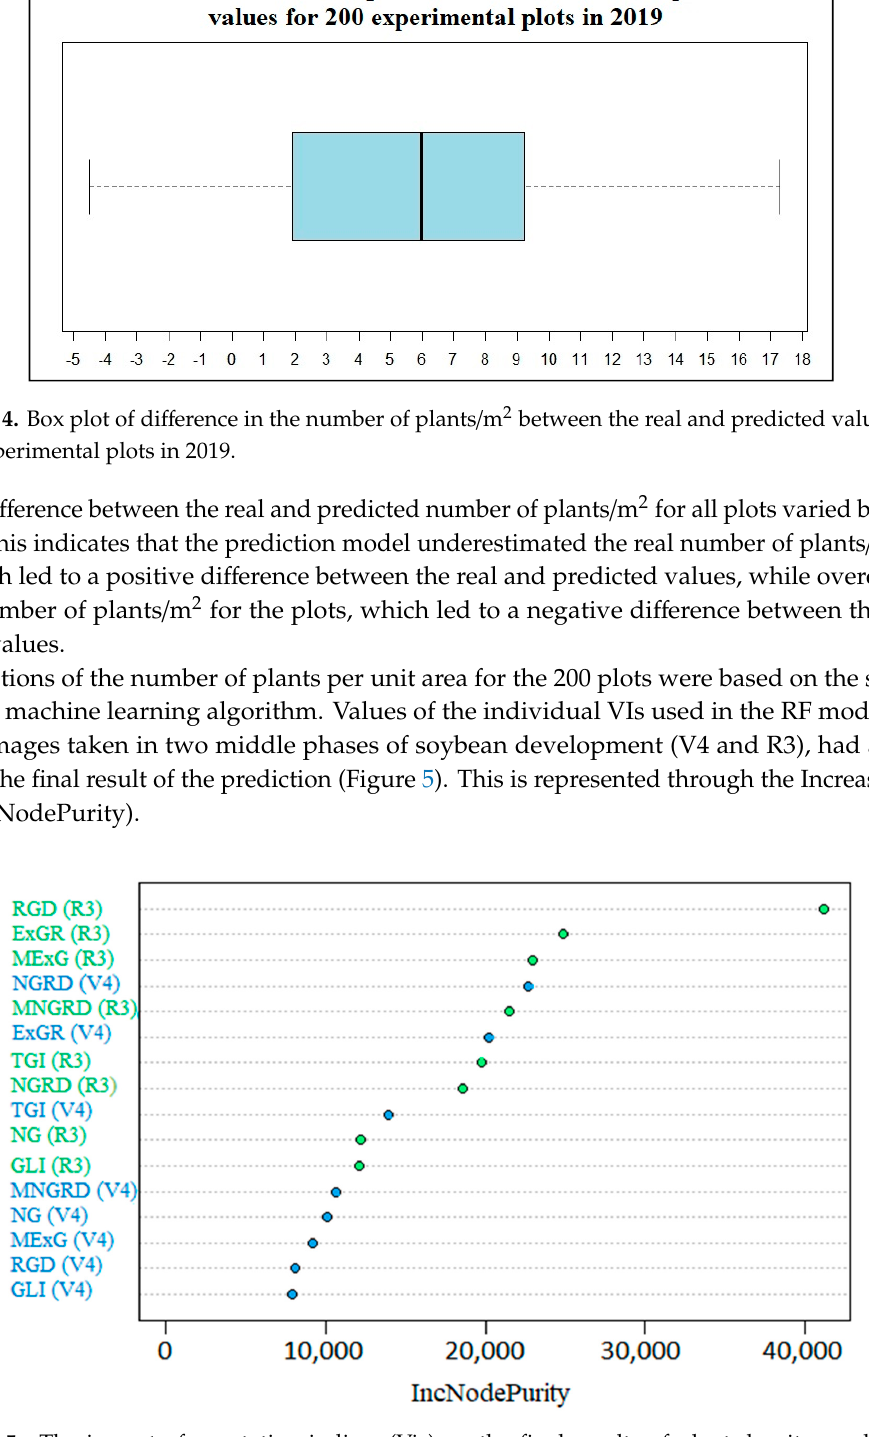
Figure 5. The impact of vegetation indices (Vis) on the final results of plant density prediction, shown through the Increase in Node Purity (IncNodePurity). (V4) and (R3) next to the names of the VIs represent two middle phases of soybean development from which the indices were obtained.